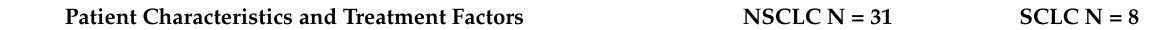
Table 1. Patients and treatment. Abbreviations: EQD 2 : biologically equivalent dose in 2 Gy fractions, V20 total lung : total lung volume that receives 20 Gy or more, V25 heart : heart volume that receives 25 Gy or more; * including one patient with unknown